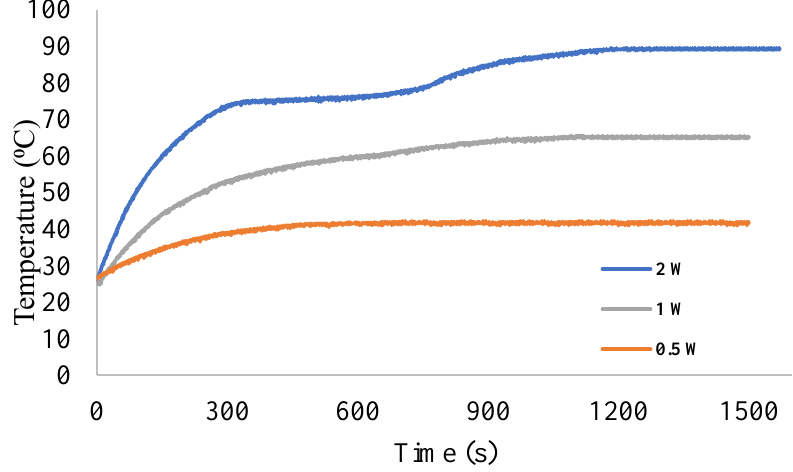
Figure 9. Temperature distribution for the heat sink with Arachidic acid for 0.5, 1 and 2 W. The temperature profiles for the heat sink without PCM, the heat sink with potassium mixture as PCM, the heat sink with sodium mixture as PCM and the heat sink with Arachidic acid as PCM for 0.5, 1 and 2 W of heat dissipated are depicted in Figures 10–12, respectively.